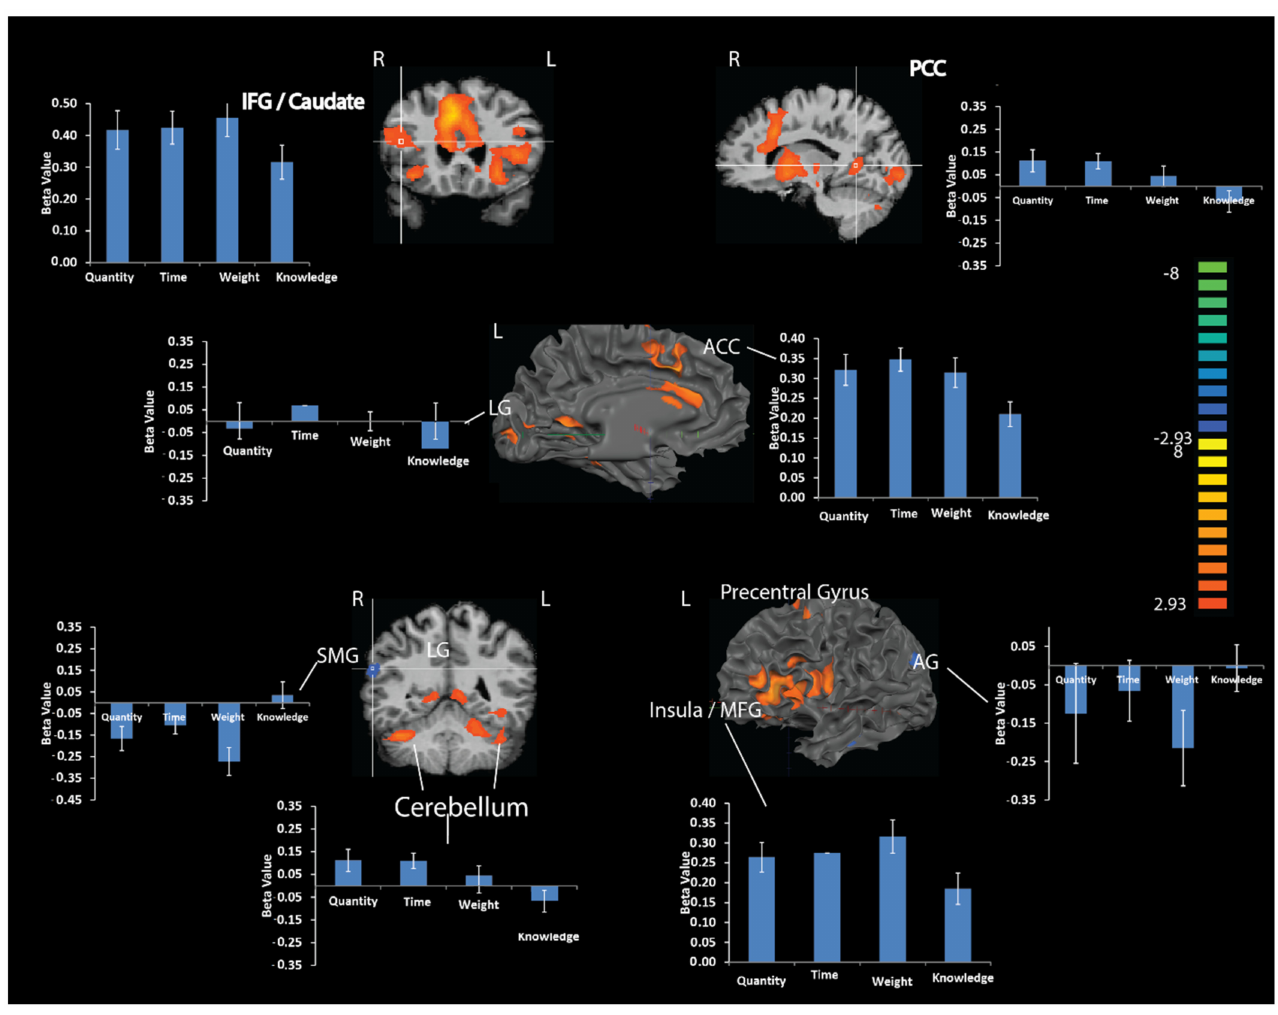
Figure 4. Brain activations associated with numerical estimation vs. weight or time